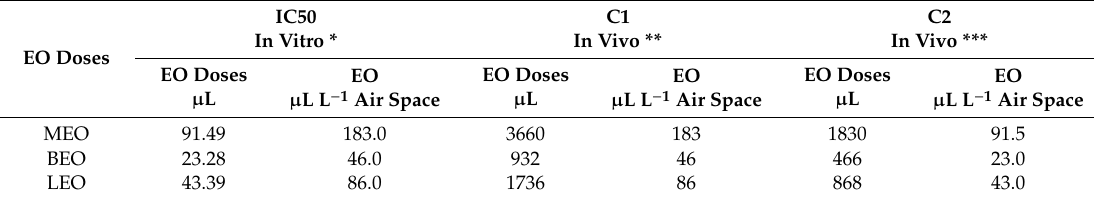
Table 5. Doses and concentrations of EOs used for the in vivo study of lemon preservation in vapor-phase modified